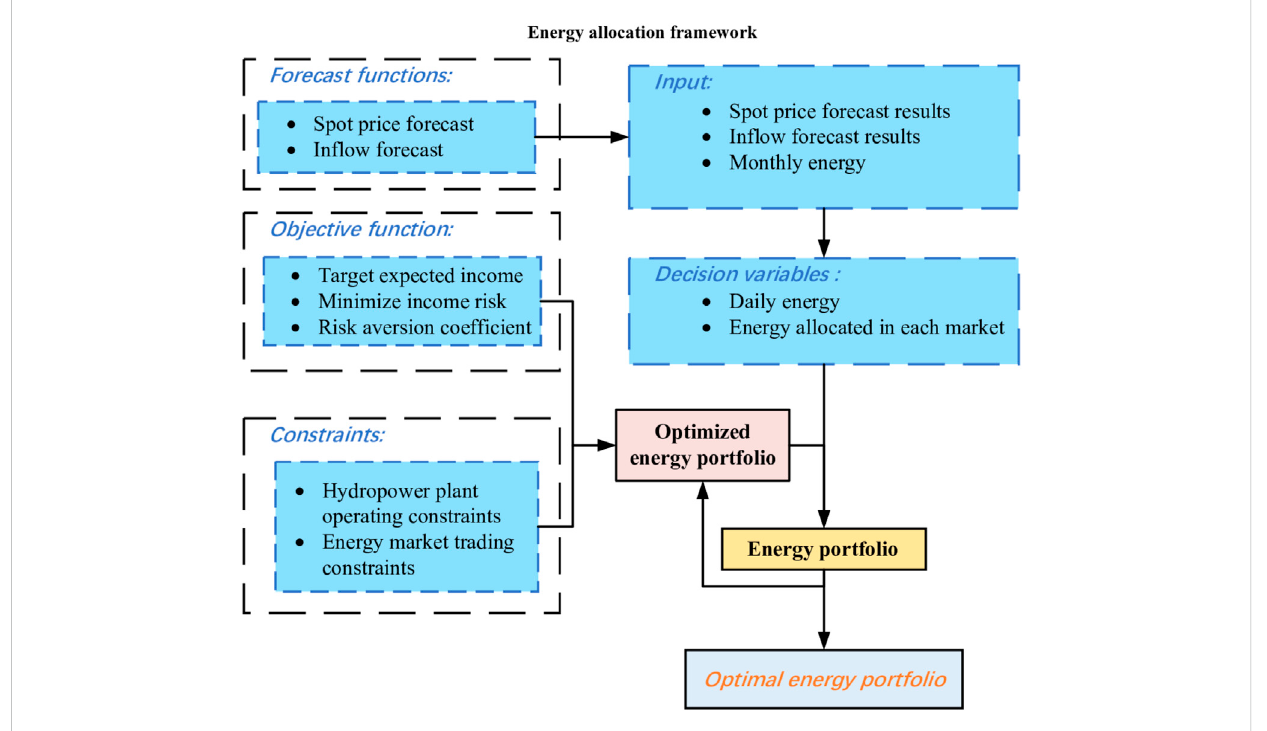
FIGURE 1 Regulable hydropower plants ’